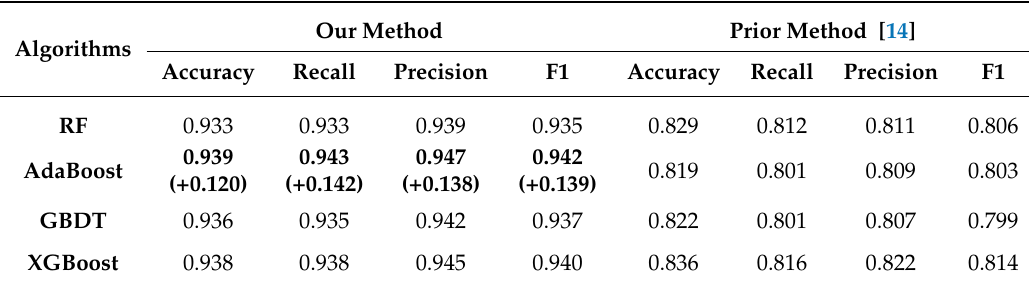
Table 7. Results of step identification within an action on the Alipay